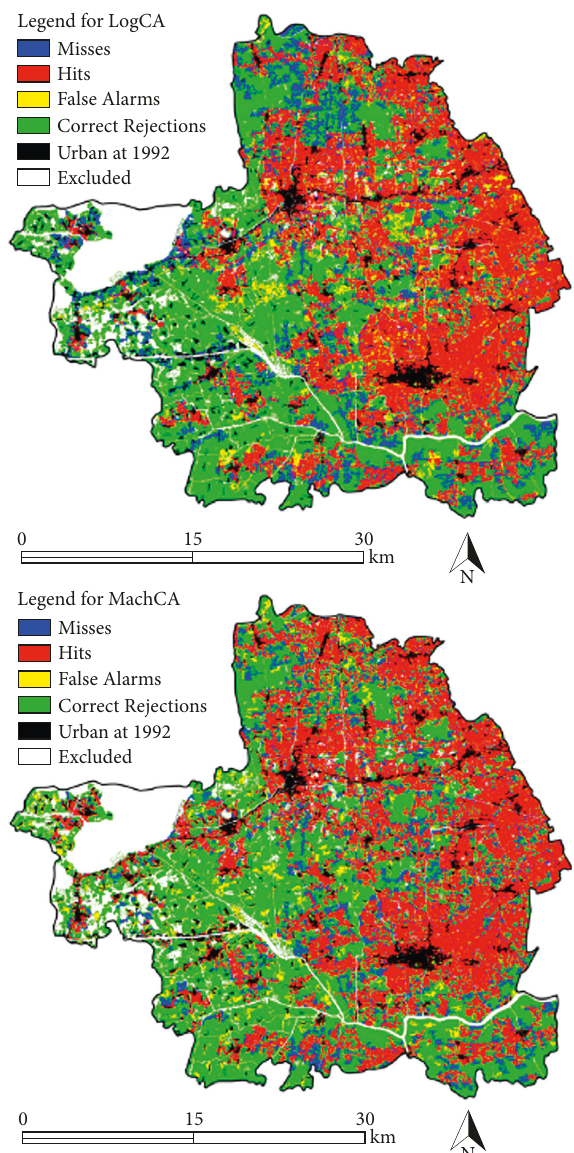
Figure 2: In 2008, metropolitan growth in the Qingpu-Songjiang area was projected using LogCA and MachCA models. Land use whose nomenclature is “excluded” shows water masses and wetlands. Hits (H) show that the increase observed was projected like growth. Misses (M) show that increase observed was projected like persistence. False alarms (FAs) show that the persistence observed was projected like growth. Correct rejections (CRs) show that persistence observed was projected like persistence (after Chen and Pontius 2010)